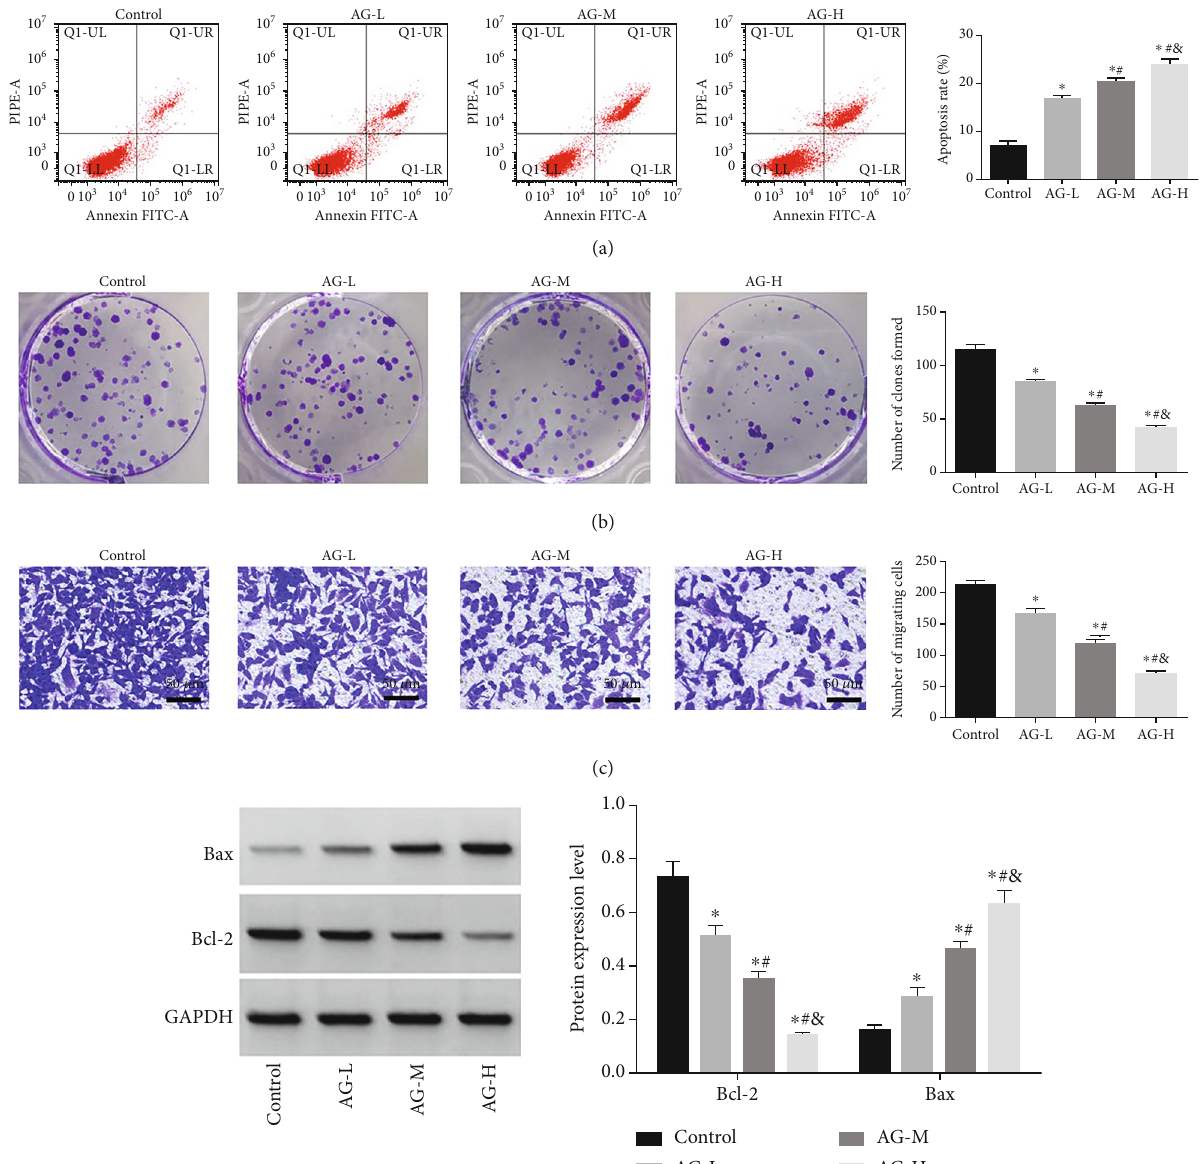
Figure 2: Impact of Amarogentin (AG) on HGC-27 apoptosis, cloning and migration a: Impact of AG on HGC-27 apoptosis. b: Impact of AG on HGC-27 clone number. c: Impact of AG on HGC-27 migration. d: Impact of AG on expression of Bax and Bcl-2 protein in HGC-27. ∗ P < 0.05 vs. control group; # P < 0.05 vs. AG-L group; & P < 0.05 vs. AG-M